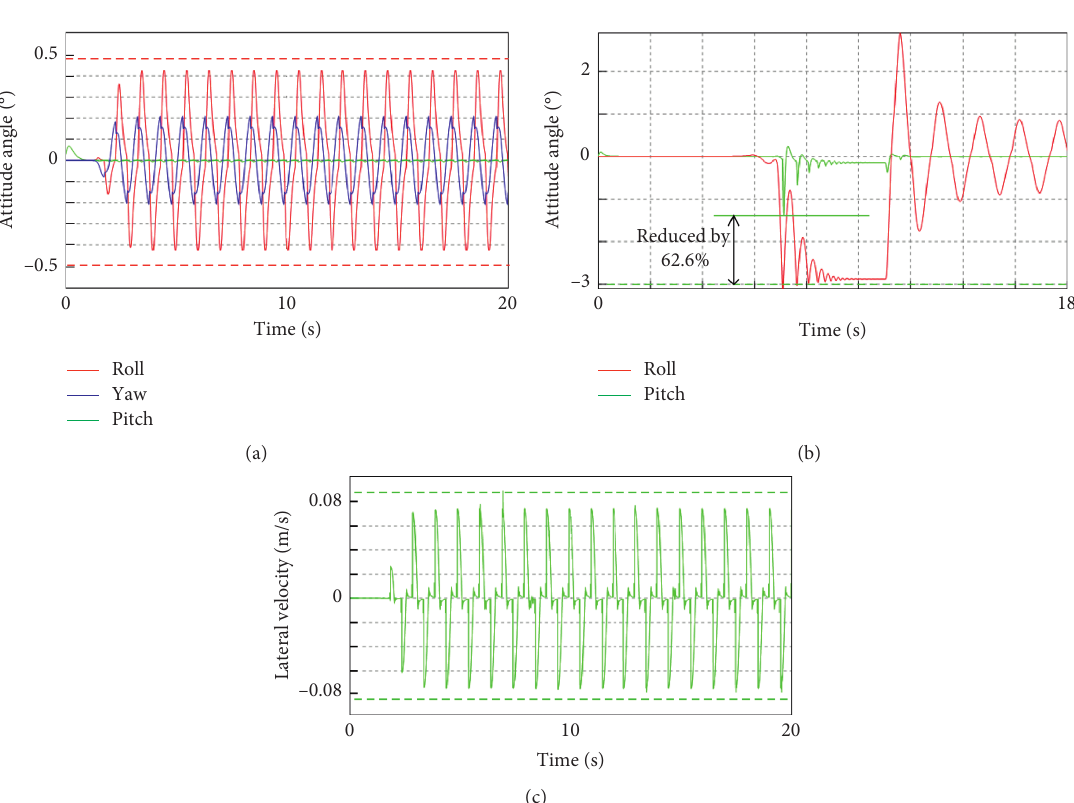
Figure 25: Simulation results of the double-bogie vehicle. (a) Changes of the attitude angle on straight driving. (b) Changes of the attitude angle on bend driving. (c) Changes of the lateral velocity on straight driving.